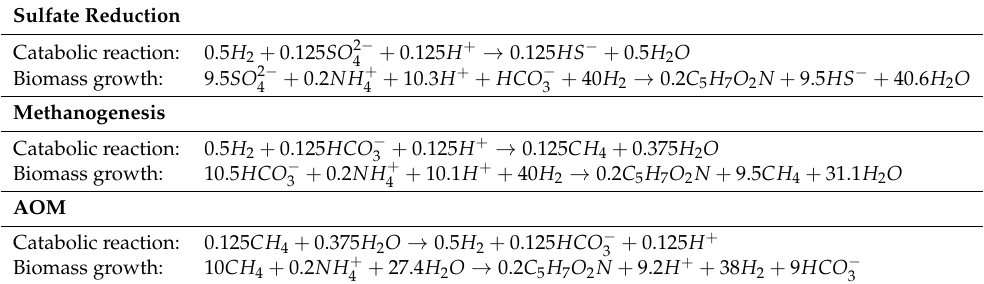
Table 1. Main microbially-mediated reactions related to biomass growth. The catabolic reactions provide the energy to synthesise biomass ( C 5 H 7 O 2 N ). Adapted from